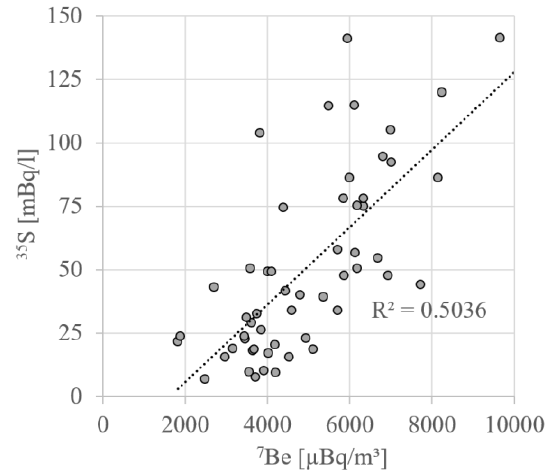
Figure 6. Correlation of 7 Be and 35 S (not considering the anomalous June 2020 peak of 35 S).